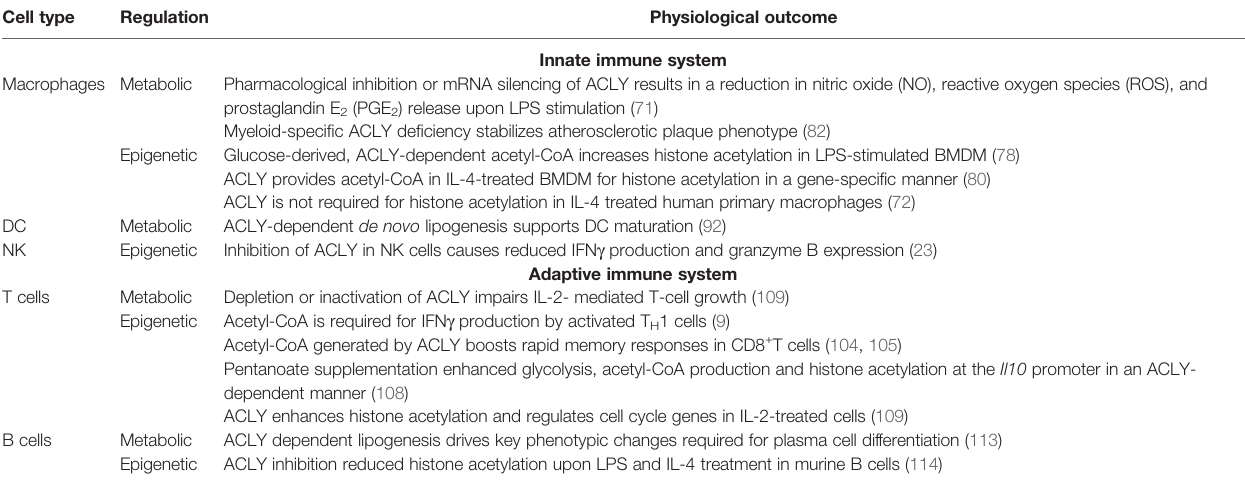
TABLE 1 | Summary of ACLY roles in immune